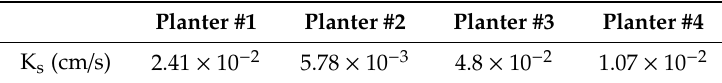
Table 3. Saturated hydraulic conductivity for each planter.